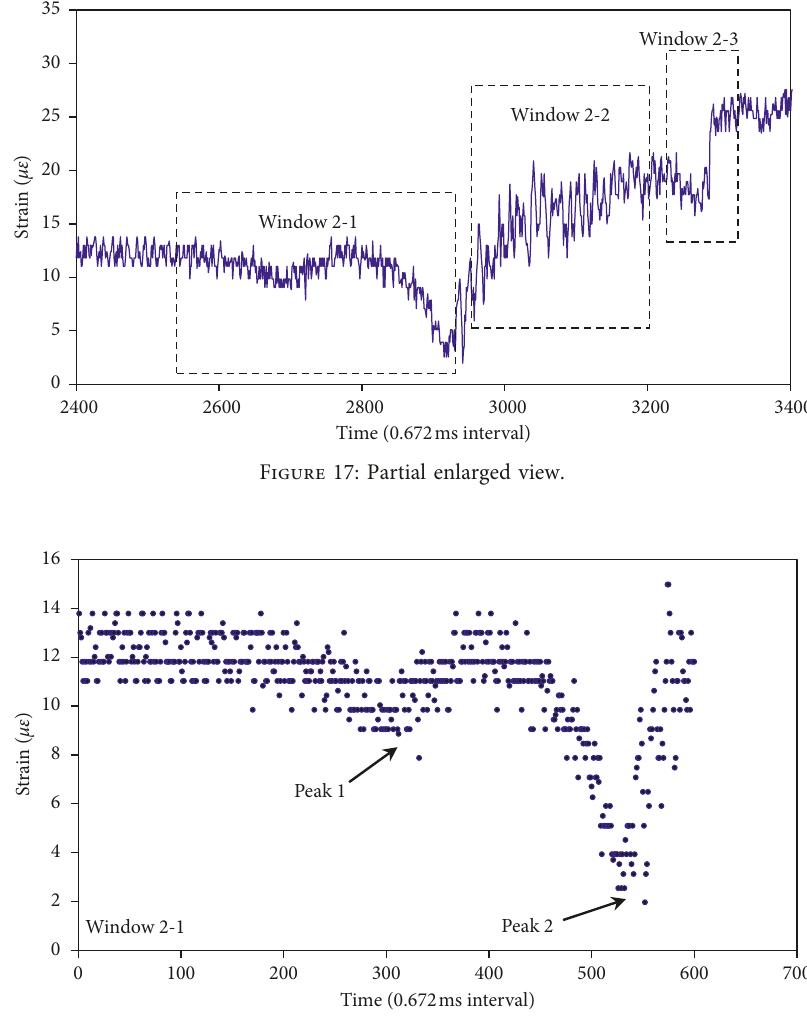
Figure 18: Overpressure phase.